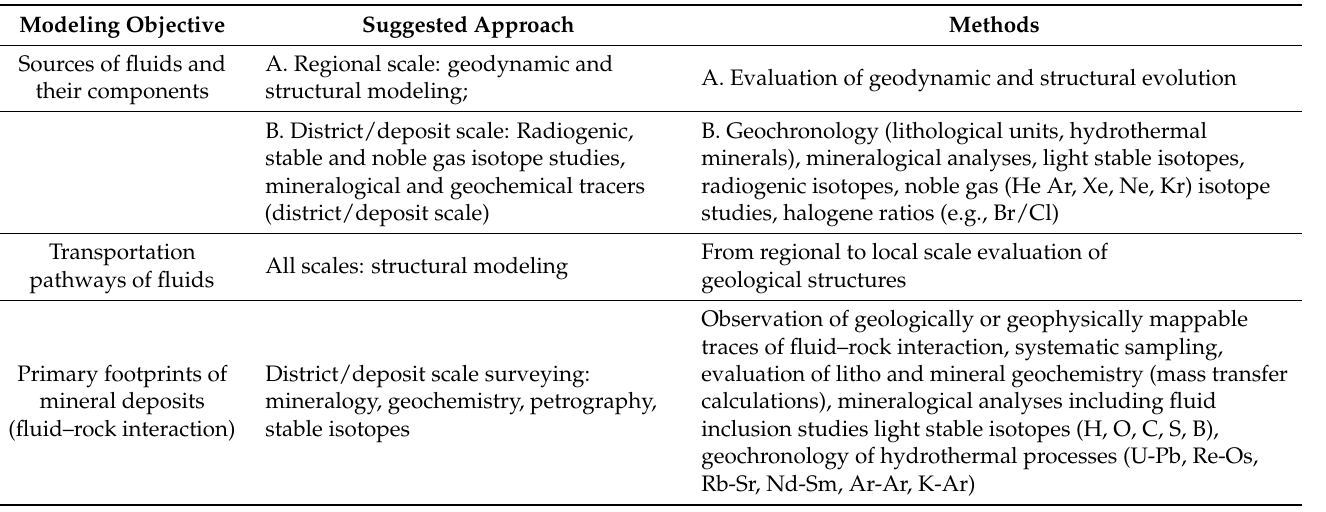
Table 8. Exploration models, approaches and methods of mineral system